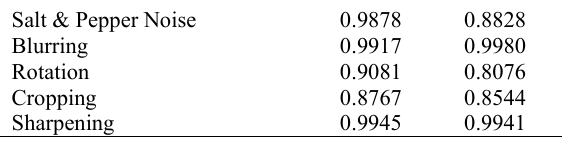
Table 3. The result of common image processing attacks on Lena Image size '512x512' with JMI logo